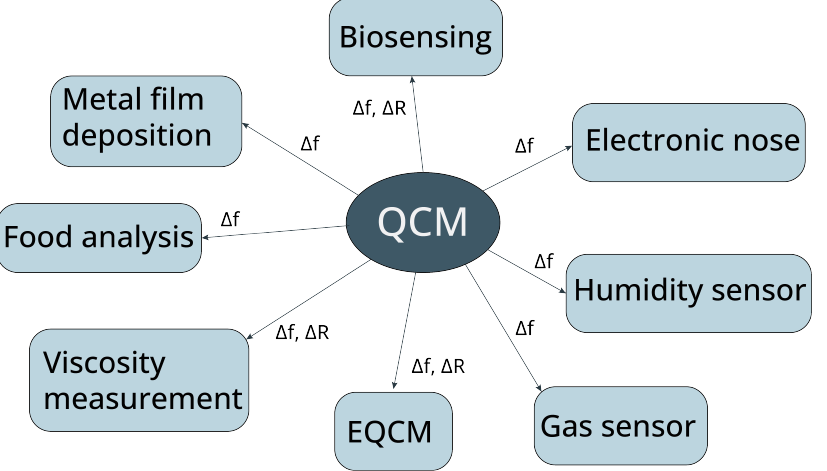
Figure 1. Measured parameters for QCM sensing applications. ∆ f is the QCM resonant frequency shift, and ∆ R is the QCM equivalent resistance